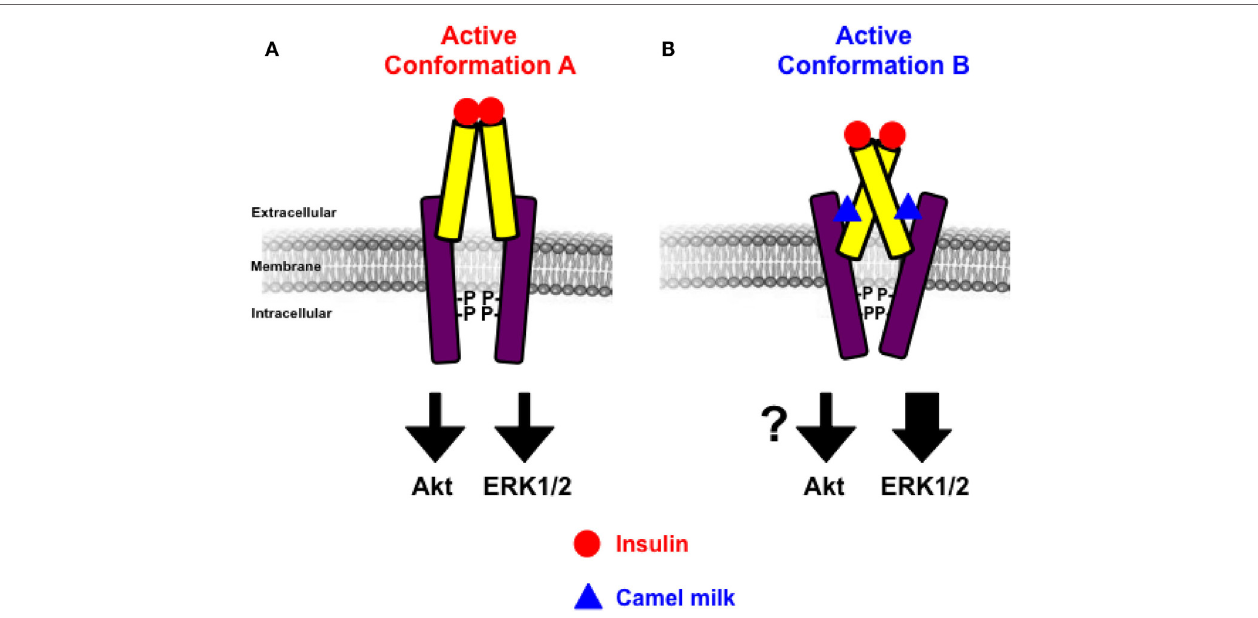
FigUre 7 | schematic model of allosteric action of camel milk on hir. The positive allosteric action of camel milk implies induction/stabilization of specific conformation of hIR with an impact on its downstream signaling. Indeed, in the presence of camel milk the conformation of hIR ( conformation B ) (B) is more efficient with regard to insulin-promoted ERK1/2 activation, but probably not Akt, compared to the conformation bound to insulin in the absence of camel milk component ( conformation A ) (a)